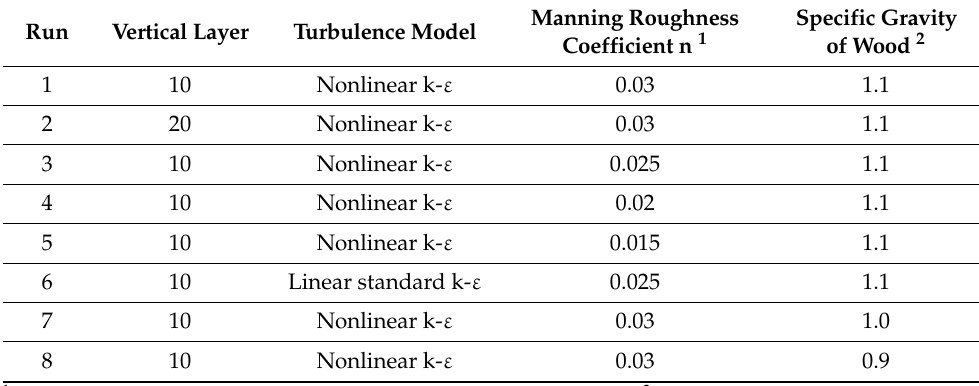
Figure 8. Plan view of computational area and grid divisions (KP denotes the river kilometer (real scale)). Table 2. Computational